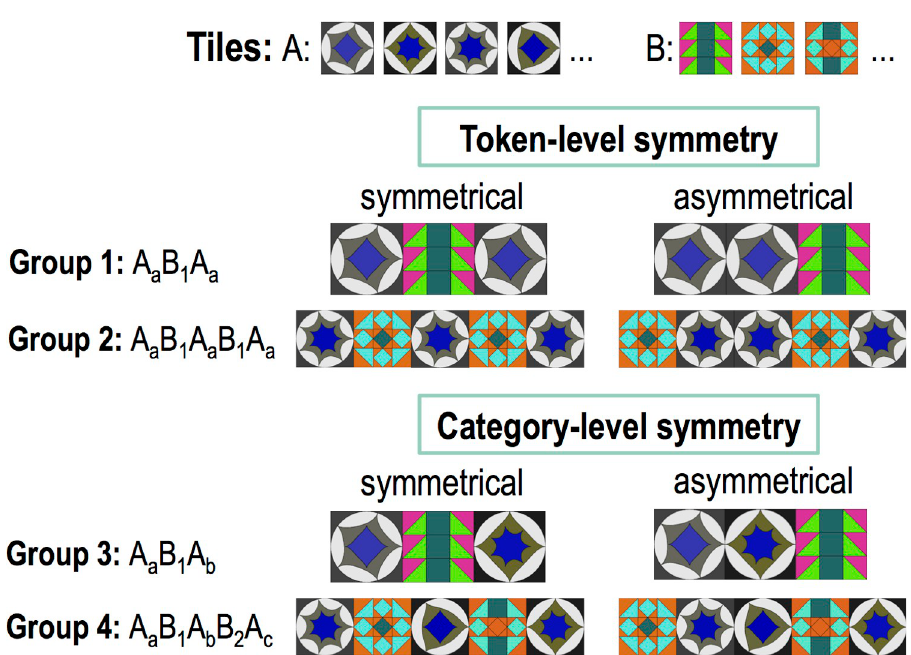
Fig 1. Stimuli. The upper panel depicts a sample of the 18 tiles used to create the mosaics, 9 per category (A or B). The middle panel depicts a sample of the mosaic-like sequences with token-level structural symmetries, and the lower panel of the mosaics with category-level structural